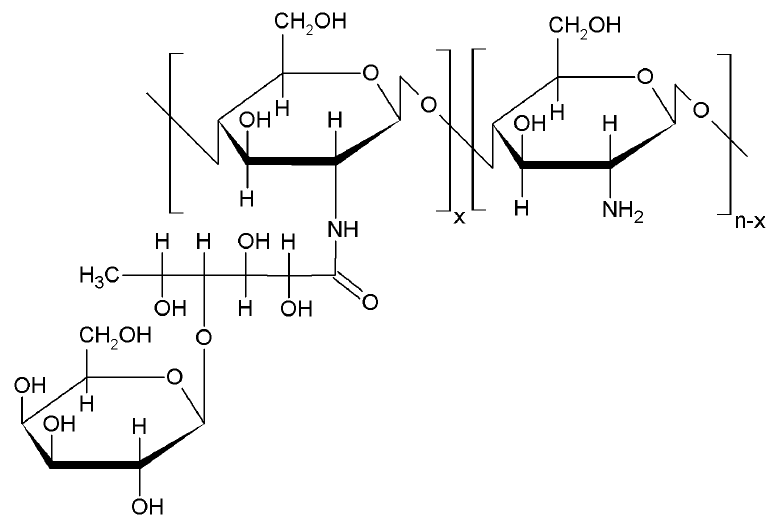
Figure 9. Chemical structure of galactosylated chitosan.